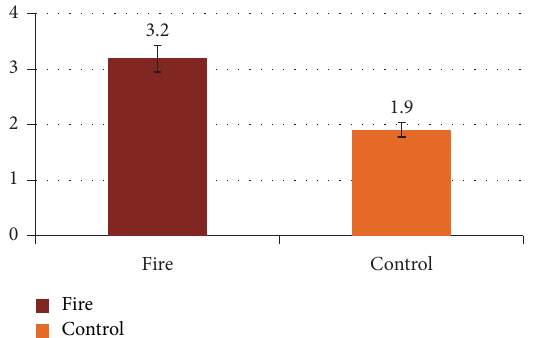
Figure 7: Benzo(a)pyrene content in control and fire-affected soils (folic horizons), ng/g.